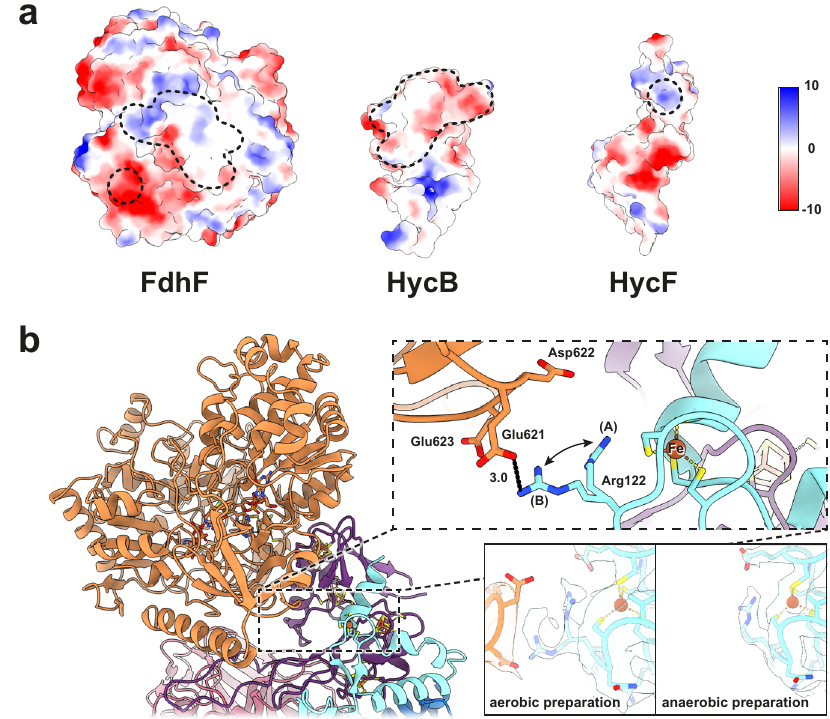
Fig. 4 | The formate dehydrogenase H (FdhF) interacts with HycB and HycF. a Electrostatic potential representation of FdhF, HycB, and HycF; the interface between the subunits is outlined with dashed lines. HycB and FdhF interact via large hydrophobic patches and H-bonds (Supplementary Fig. 5). Electrostatic interactions occur between a small electropositive region of HycF and an elec- tronegativepatchofFdhF. b DetailedviewoftheinteractionsitebetweenFdhFand